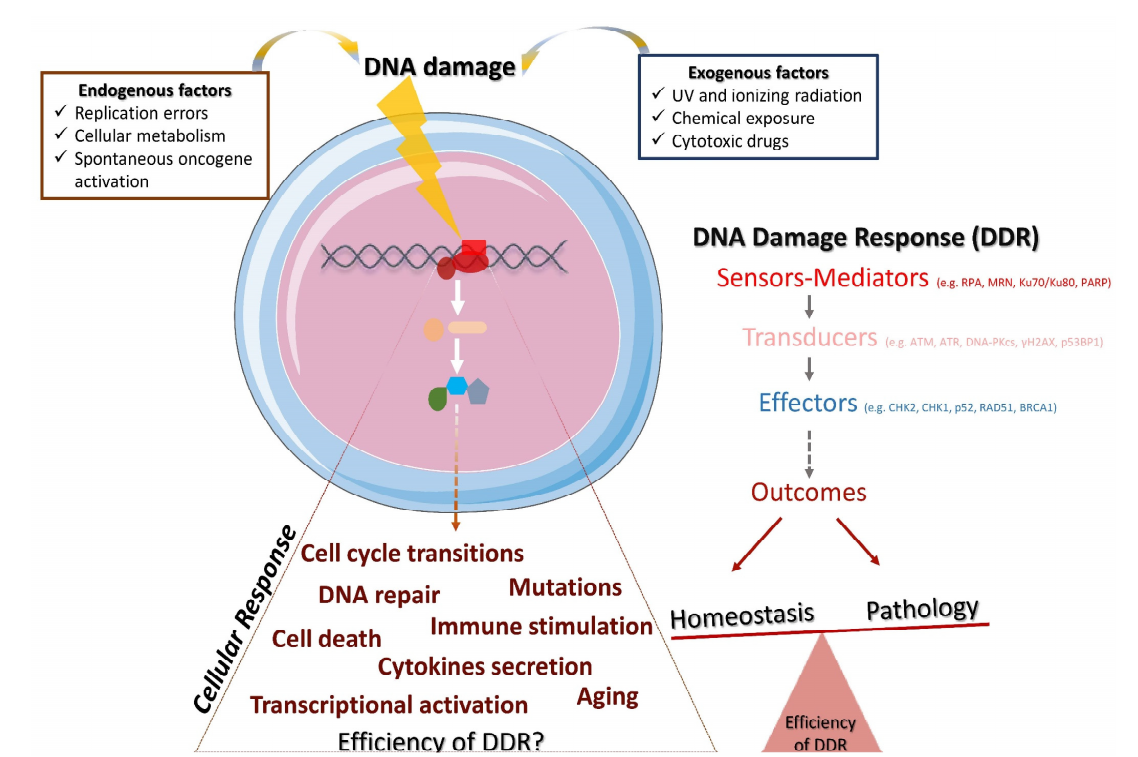
Figure 1. The DDR and its implications for homeostasis and pathology. Endogenous and/or exogenous factors threaten genome stability and trigger DDR. DDR is accomplished through the hierarchical activation of various molecules, namely, the DNA damage sensors and mediators, the transducers of the signaling and the effectors that carry out the outcome. Depending on the efficiency of the DDR and the cellular response, the potential outcomes may lead to the restoration of the homeostasis or to